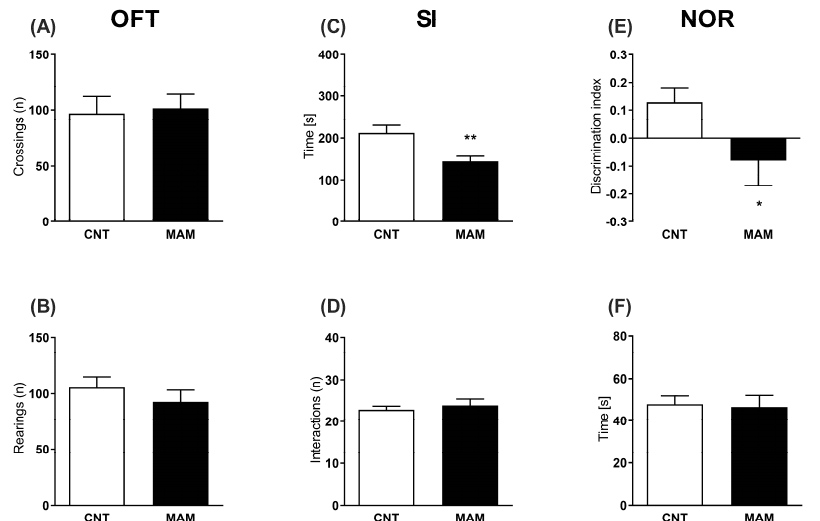
Figure 3. Effects of perinatal MAM exposure on the behavioral phenotype of rats that were tested ( A , B ) in the open field test (OFT), ( C , D ) in the social interaction (SI) test, and ( E , F ) in the novel object recognition (NOR) test at adulthood. Data are presented as means ± S.E.M. ( n = 9–15). * p < 0.05 and ** p < 0.01 vs. CNT.